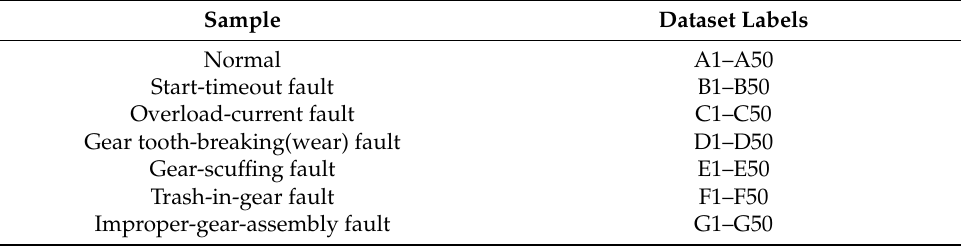
Table 5. Signal-dataset classification of the grille